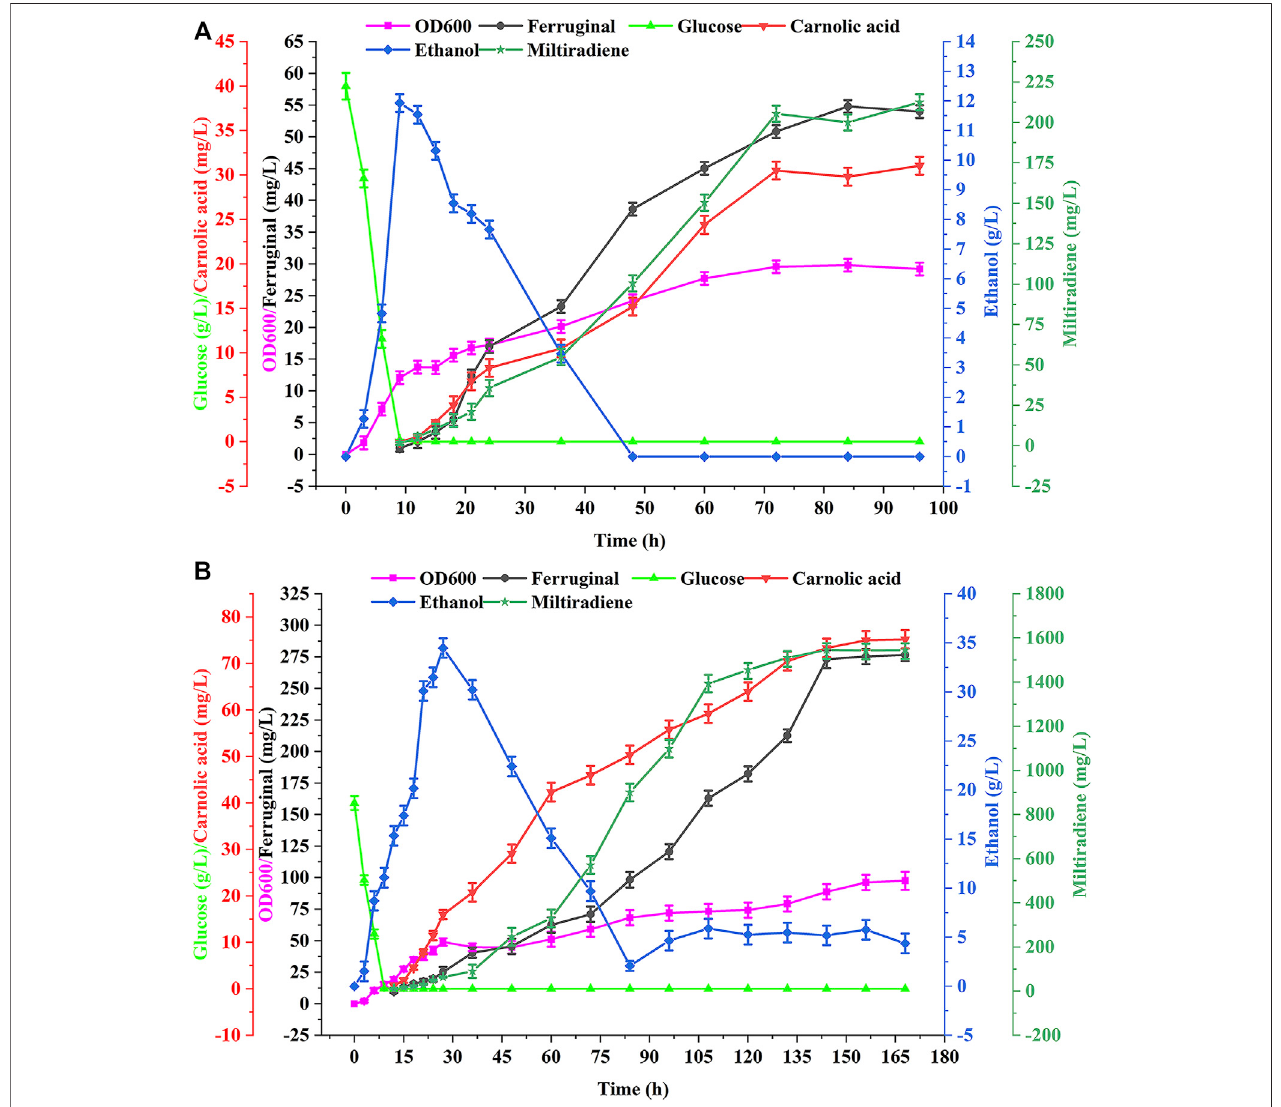
FIGURE 7 | Production of CA in batch and fed-batch fermentations in a 5 L bioreactor. (A) Batch fermentation in a 5 L bioreactor using strain WCA11. The fermentation was conducted in YPD medium with 40 g/L glucose. (B) WCA11 fed-batch fermentation in a 5 L bioreactor. The data are the averages of three separate